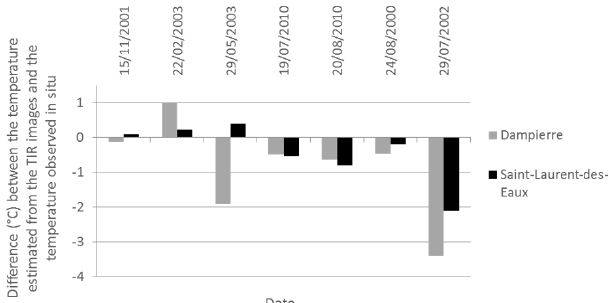
Figure 2. Differences between TIR-derived temperatures extracted from the longitudinal temperature profile and in situ measurements (at the same date and time) for each date and at two different sites (Dampierre and Saint-Laurent-des-Eaux). The dates are classified according to the air temperature at the time when the images were taken (air temperature rose from 15 November 2001 to 29 July